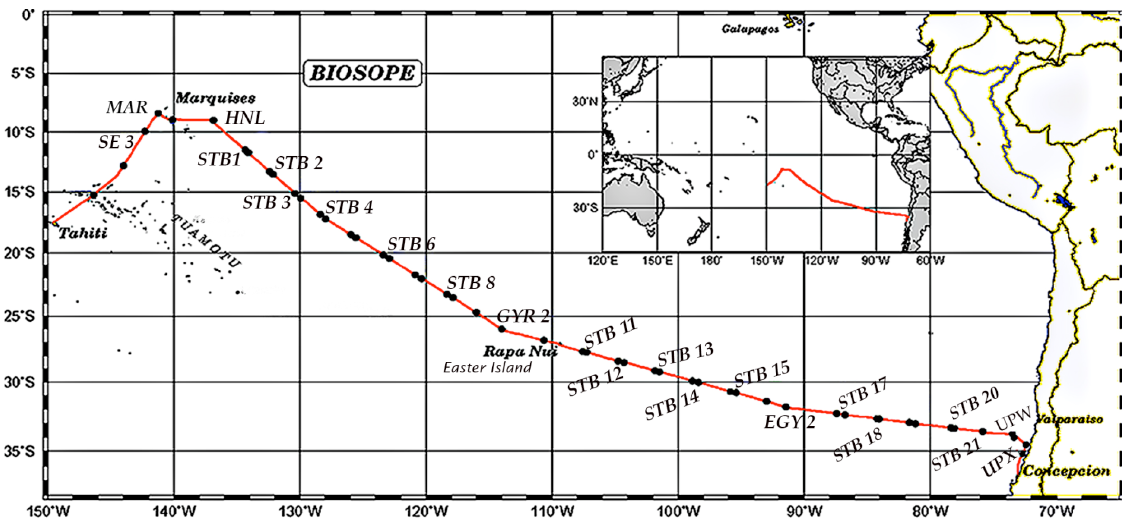
Fig. 1. BIOSOPE cruise track showing stations at which samples for tintinnid ciliates were obtained. Station locations and sampling dates are given in Table 1.